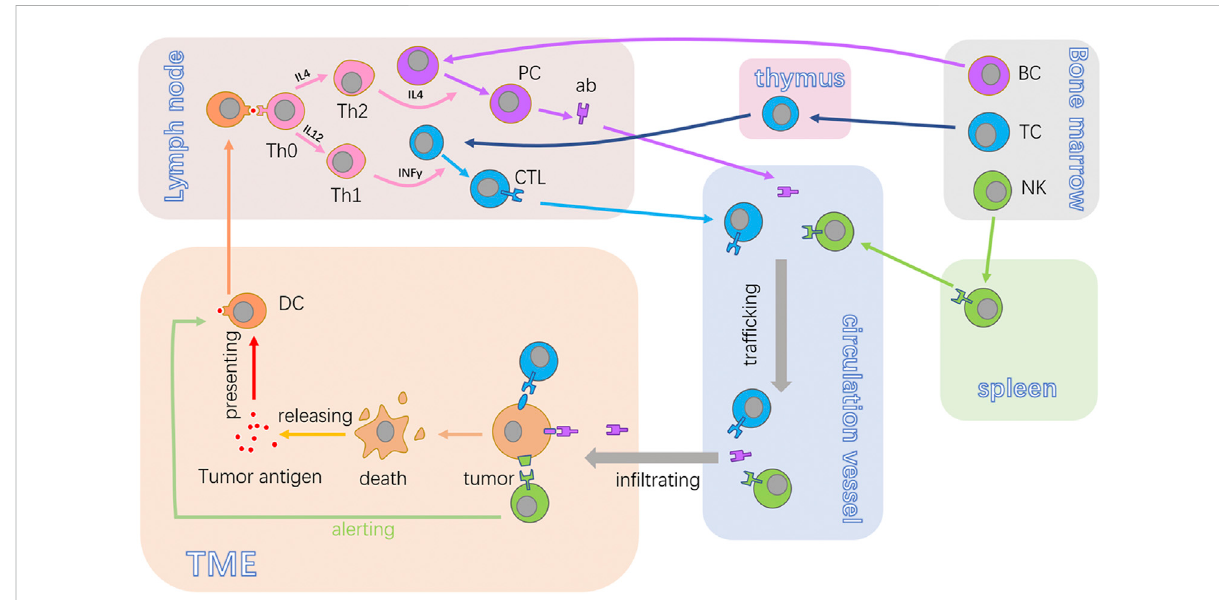
FIGURE 2 Anticancercycleofimmunocytes.BC,TC,andNKarethefundamentalimmunocytesintumorimmunity.Theantigenreleasedfromtumorcells will be acquired by DCs. Also, DCs can present the antigen to Th0. Once activated, Th0 proliferates and differentiates into Th2 or Th1, harmonizing the activation of PC and CTL. Then, the antibodies or CTL will traf fi c to the TME and recognize target tumor cells and produce an effect. NK can recognize and kill cancer cells in non-special ways. BC, B lymphocytes; TC, T lymphocyte; NK, natural killer cells; ab, antibody; CTL, cytotoxic lymphocyte; PC, plasma cell; TME, tumor microenvironment; DC, dendritic cell; Th0, non-differentiated type-0 cell; Th1, type 1 T helper cell; Th2, type 2 T helper